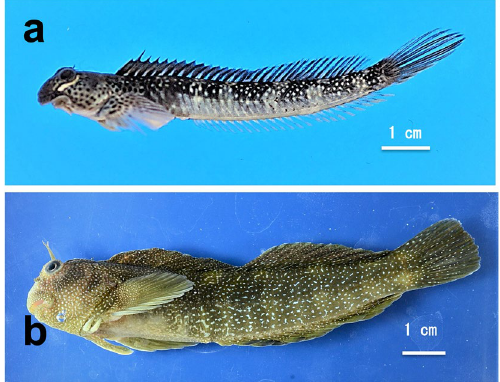
Figure 1. ( a ) Andamia tetradactylus, 82 mm. (b ) Entomacrodus stellifer, 108